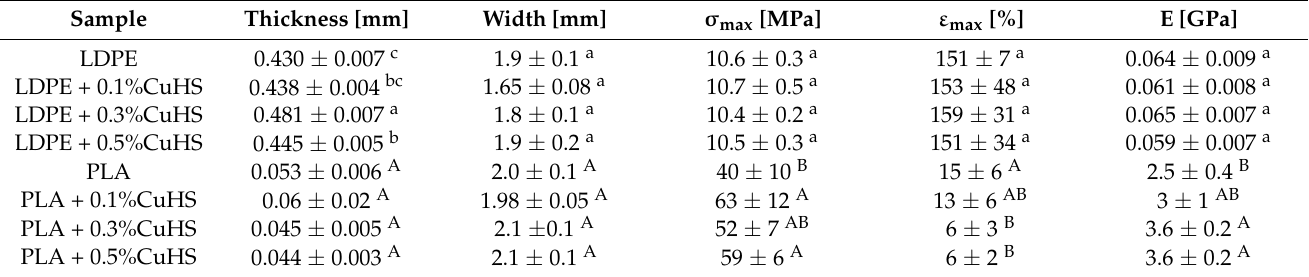
Table 2. Thickness and width of the specimens tested in the mechanical analysis, as well as the main results obtained from this test. The standard deviation is for five independent samples. Similar letters/symbols mean no statistical significance, while different letters/symbols mean statistical